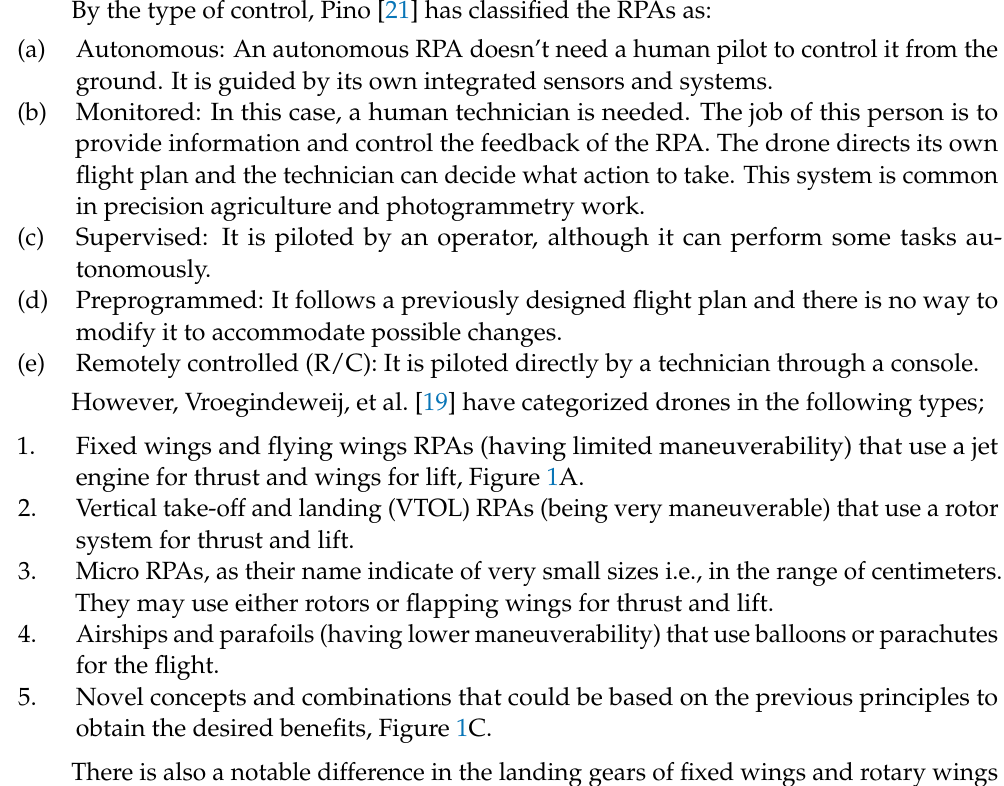
Figure 1. Illustration of basic RPA types ( A ) Fixed wing RPA ( B ) Rotary wing RPA ( C ) Combinational con- cepts.